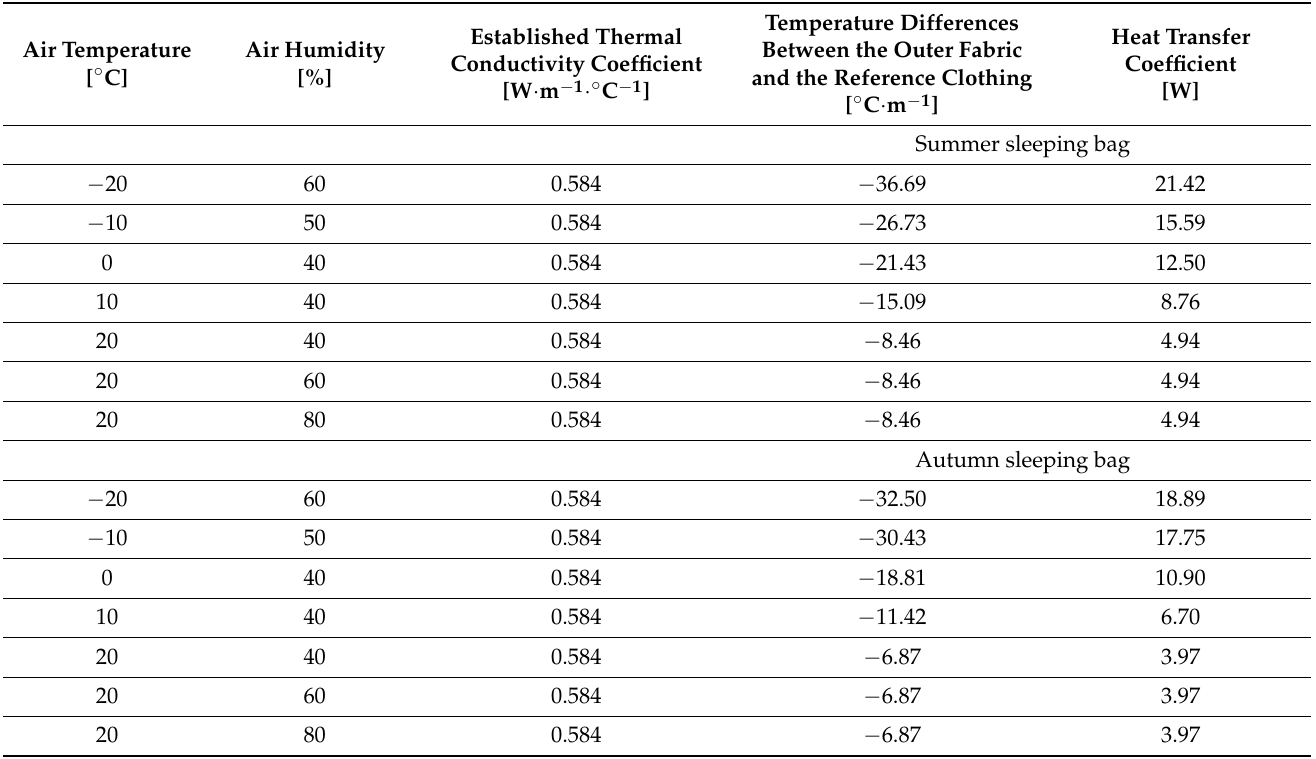
Table 4. Summary of the thermal conductivity coefficient and the temperature gradient of the tested sleeping bags.